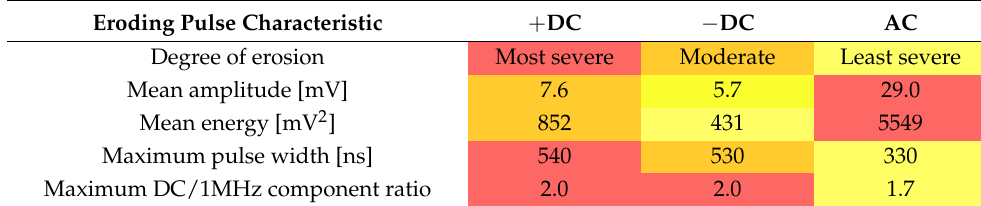
Table 6. Summary of eroding discharge pulse characteristics obtained in AC, negative and positive DC tests. Red, orange and yellow cells indicate the relative order of values in each row from high to low,